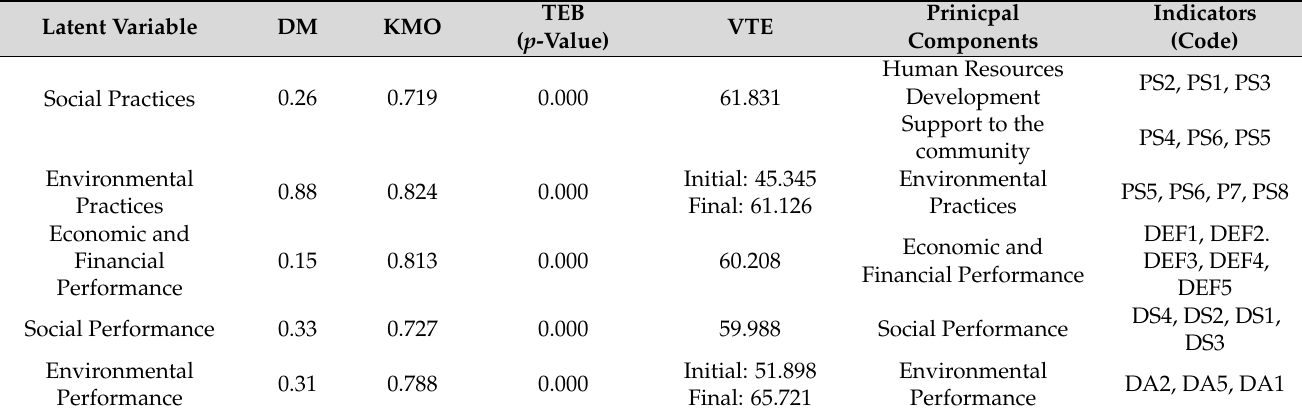
Table 7. Factor analysis and principal components